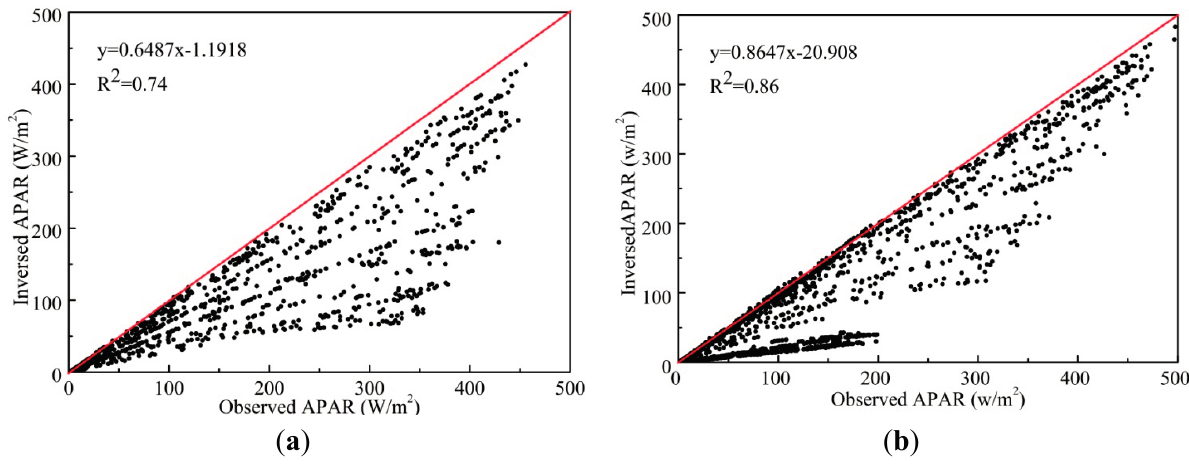
Figure 8. Scatterplots of inversed and observed APAR with an underlying surface of: ( a ) cropland; ( b ) meadowland.4.4. Validation with the MODIS FPAR